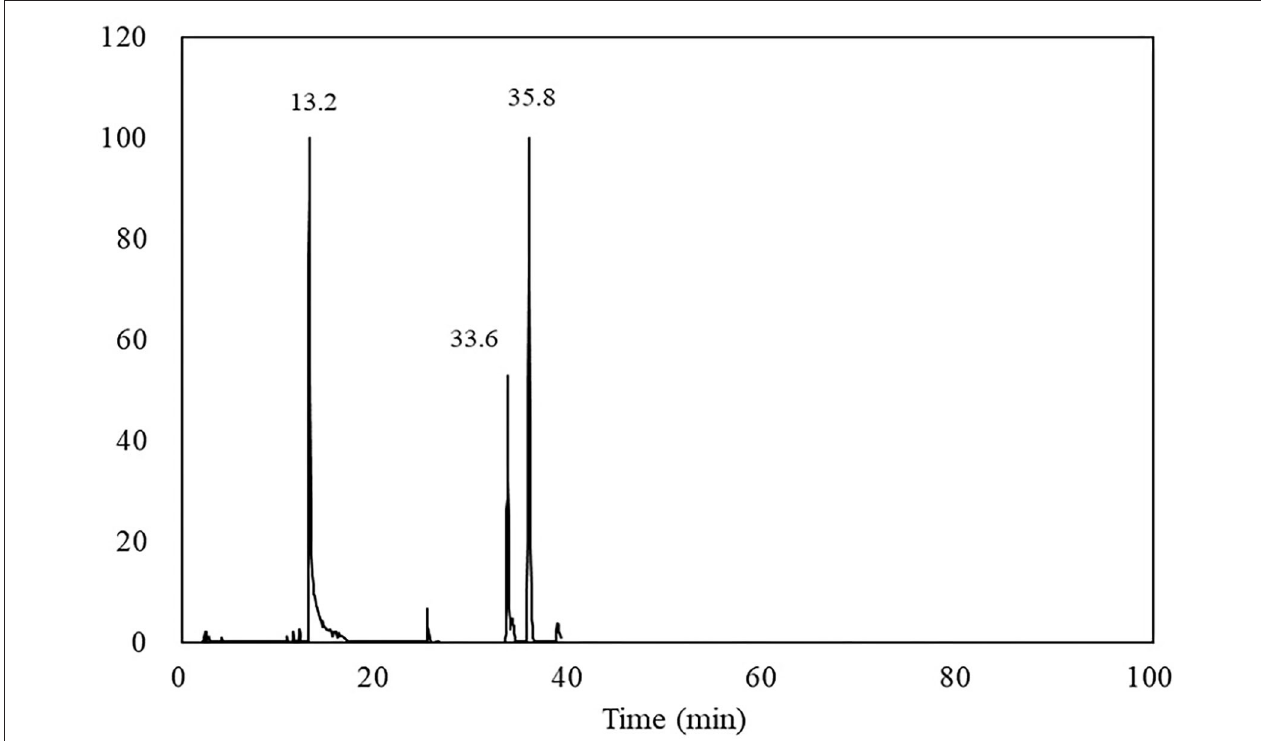
FIGURE 5 | Chromatographic profile of the phenolic compounds found in the dried Bollén leaves: Ursolic acid methylester (C 31 H 50 O 3 ) with Rt = 33.6 and 35.8min, and Prunasin (C 14 H 17 NO 6 ) with Rt =